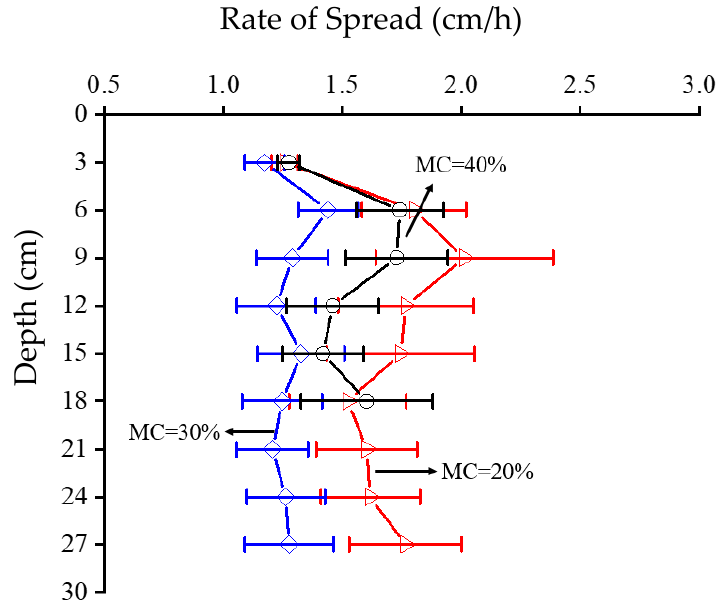
Figure 5. Average (and range) rates of spread of samples for depth of beds (cm).